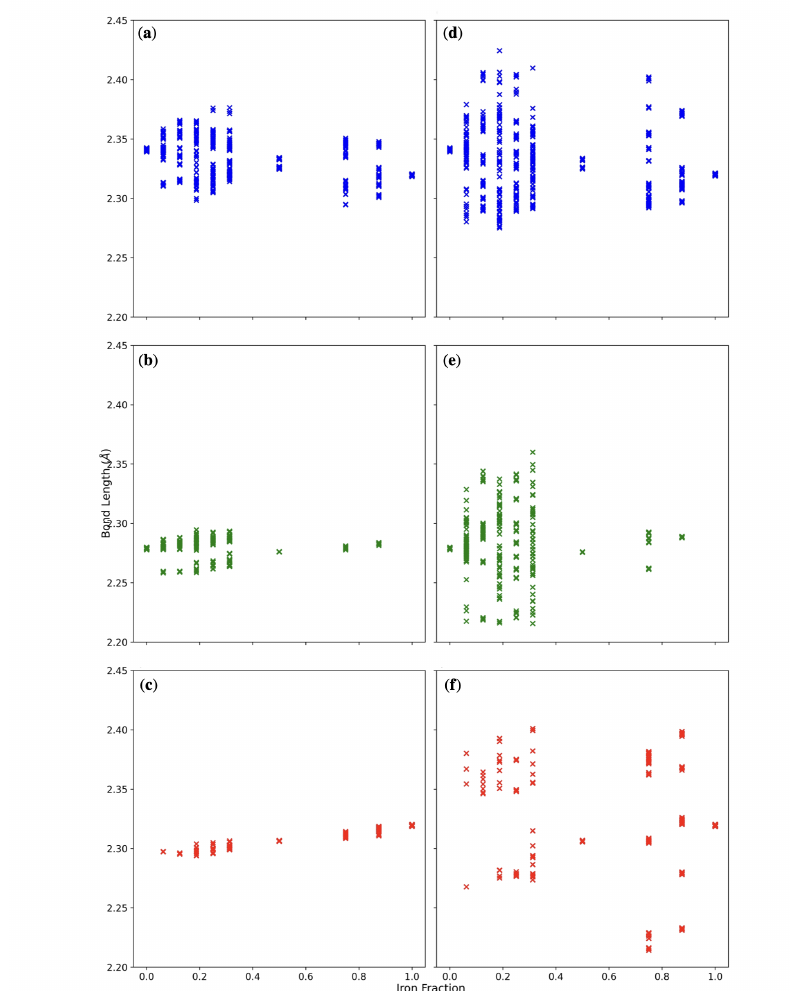
Figure A6. ( a ) Cu-S bond lengths in [ Fe Al ] 0 substituted CuAl 1 − p Fe p S 2 ; ( b ) Al-S bond lengths in [ Fe Al ] 0 substituted CuAl 1 − p Fe p S 2 ; ( c ) Fe-S bond lengths in [ Fe Al ] 0 substituted CuAl 1 − p Fe p S 2 ; ( d ) Cu-S bond lengths in [ Fe Cu ] 2 + + [ Cu Al ] 2 − substituted CuAl 1 − p Fe p S 2 ; ( e ) Al-S bond lengths in [ Fe ] 2 + + [ Cu ] 2 − substituted CuAl Cu 1 − p Fe p S 2 ; ( f ) Fe-S bond lengths in Al tuted CuAl 1 − p Fe p S 2 .